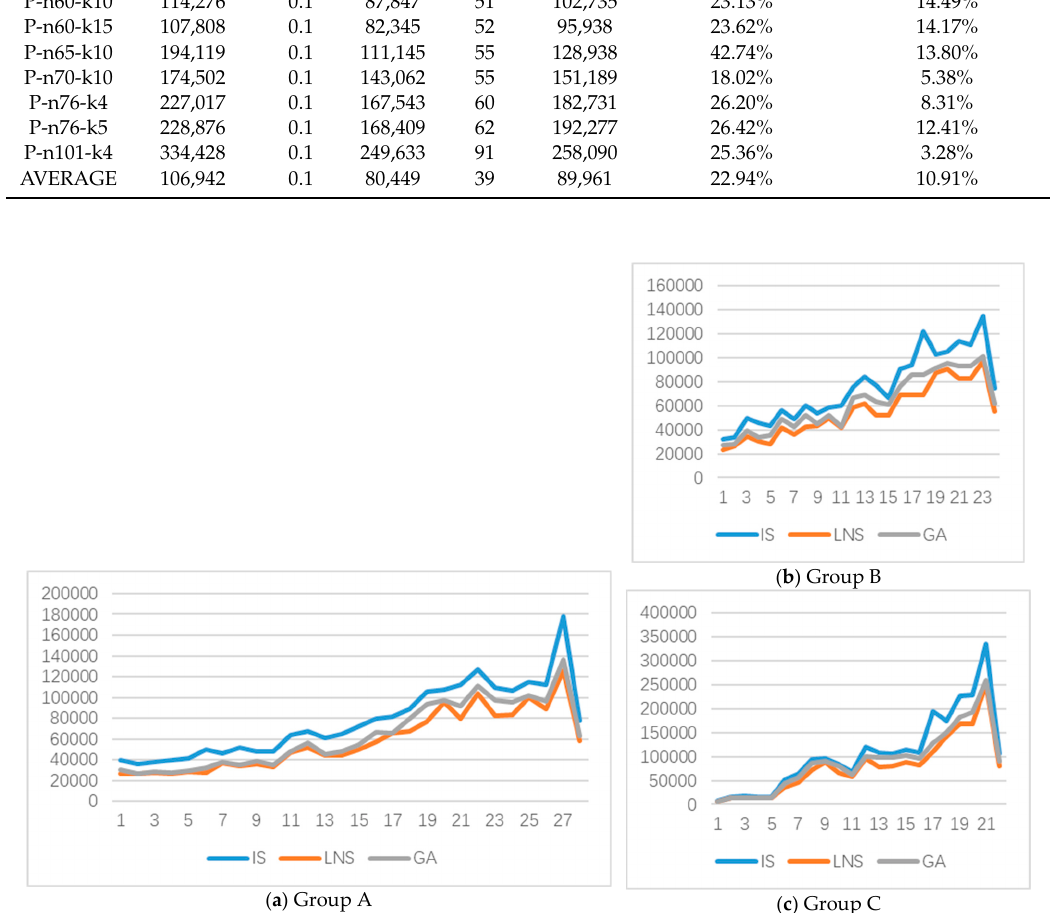
Figure 5. The tendency in the results of three algorithms (IS, ILNS, and GA).